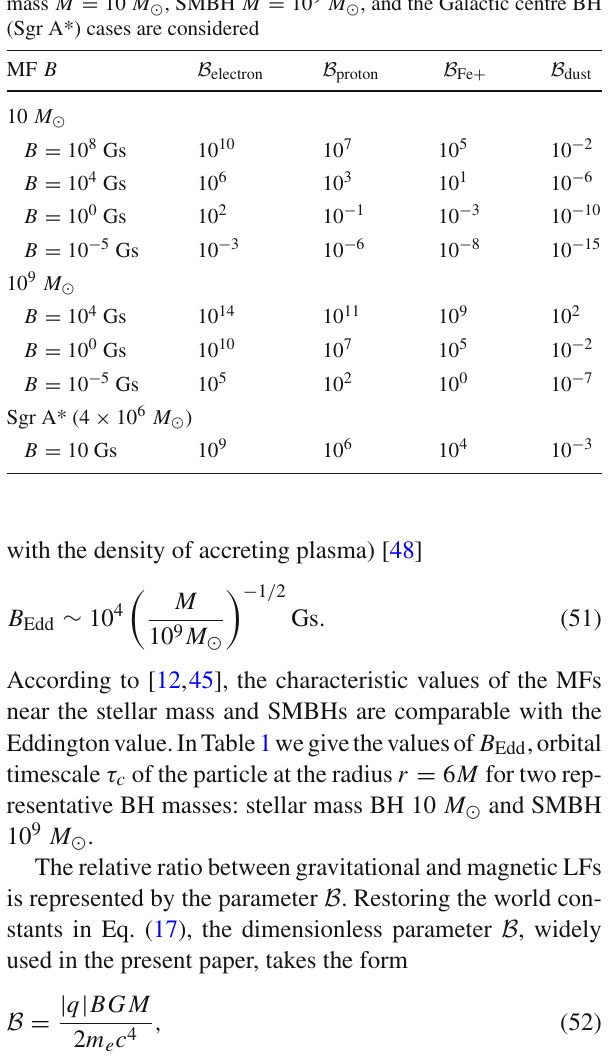
Table 2 Magnetic parameter B , Eq. (52), for various MF magnitudes and different charged particles: electron, proton, ionized iron atom (one electron lost), dust grain (one electron lost, m ∼ 10 − 18 g).